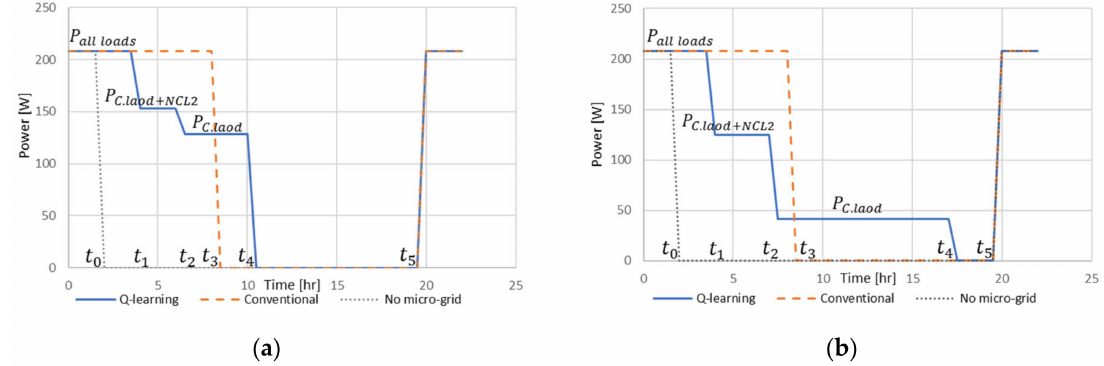
Figure 12. Results of implementation of QEMS ( a ) Critical load 62%, ( b ) Critical load